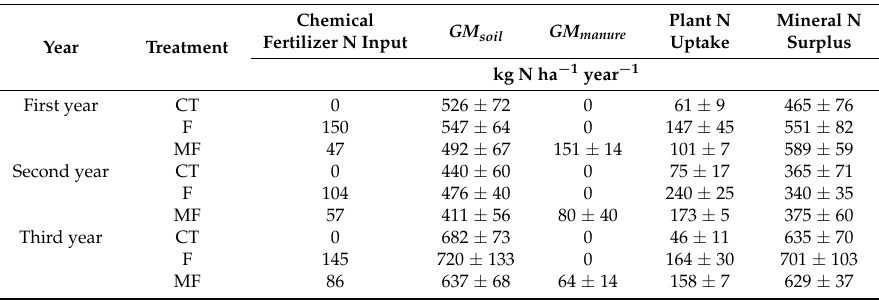
Table 5. Mineral nitrogen input, plant N uptake, and mineral N surplus after renovation in unfertilized control treatment (CT), chemical fertilizer treatment (F), and combined manure and chemical fertilizer treatment (MF). Values are mean ± standard deviation.